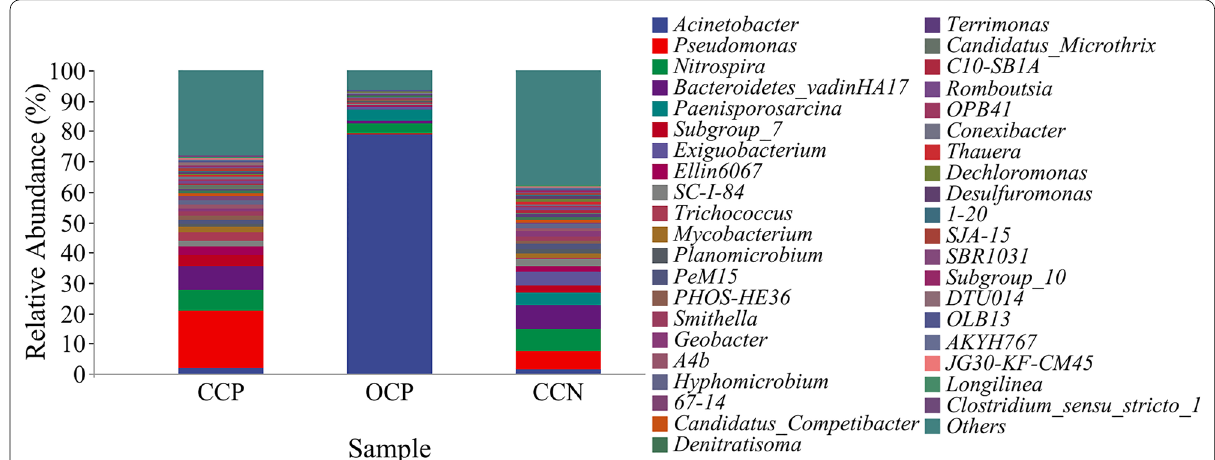
Fig. 7 Relative abundance of major genera in CCP, OCP and CCN under 16S primers. Genera with relative abundances below the top forty are defined as